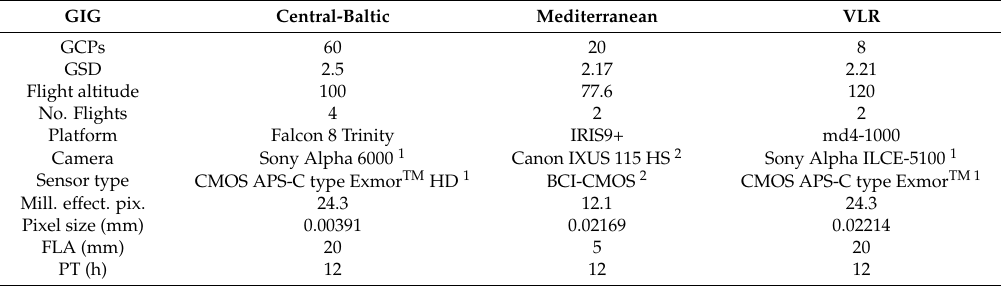
Table 3. Key characteristics of the platforms and sensors used to gather the imagery at each river reach. GIG, VLR, GCP, GSD, Mill. effect. pix. and FLA stand for Geographical Intercalibration Group, Very Large Rivers, Ground Control Point, Ground Sampling Distance, Million Effective Pixels and Focal Length Applied, respectively. The time required for the photogrammetric process (PT) is estimated based on the performance of a computer with an Intel Core i7-5820k 3.30 GHz processor, 32 Gb RAM and 2 graphic cards (Geoforce GTX 980 and Qadro K2200, NVIDIA, Santa Clara, CA, USA). 1 Sony Corporation, Tokio, Japan. 2 Canon TM , Tokio,